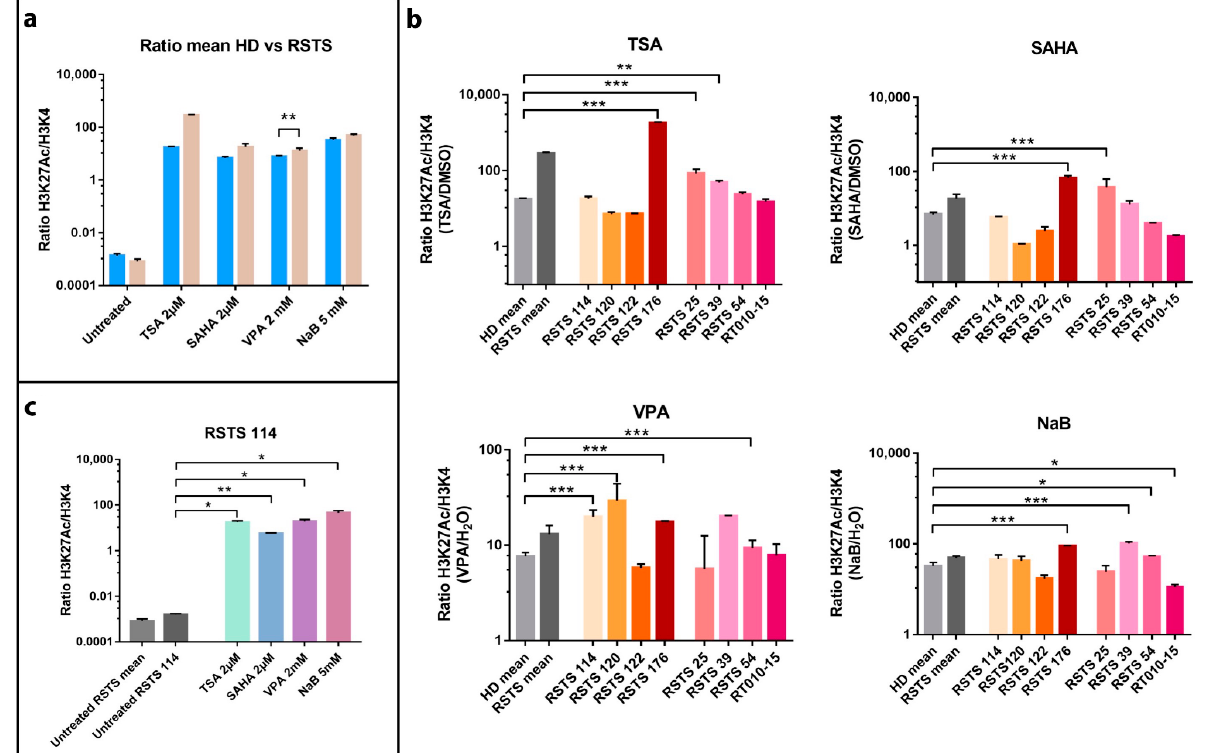
Figure 1. Histone acetylation on Rubinstein–Taybi syndrome (RSTS) lymphoblastoid cell lines (LCLs) upon acetyltrans- ferases (HAT) and deacetylases (HDAC) inhibitors exposure. H3K27 acetylation levels normalized on H3K4 unmodified, assessed by AlphaLISA ® ; levels of acetylation upon HDAC inhibitors (HDACi) are expressed as a ratio between the treatment and respective vehicle (HDACi/vehicle); on the Log scale, Y -axis H3K27 acetylation levels normalized, on X -axis lists of epigenetic treatments or untreated/treated single LCL or LCLs means. ( a ) Means of values of H3K27 acetylation in healthy donors (HD, in blue) and patients LCLs (RSTS, in pale brown) untreated and exposed to four different HDACi (trichostatin A (TSA) 2 µ M, suberoylanilide hydroxamic acid (SAHA) 2 µ M, valproic acid (VPA) 2 mM, and sodium butyrate (NaB) 5 mM). ( b ) H3K27 acetylation in eight RSTS LCLs ( CREBBP LCLs in shades of red, EP300 LCLs in shades of pink) after exposure with the four different HDACi, compared to treated HD and RSTS means. ( c ) Insight on the